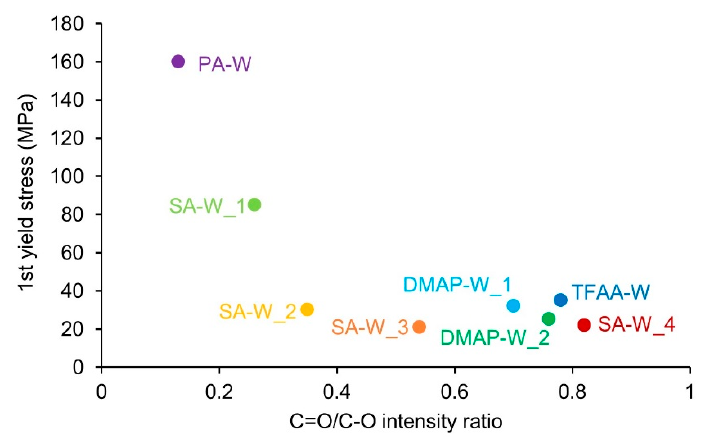
Figure 10. First yield stresses of the propionylated wood specimens, showing the ratio of the IR peak intensity derived from the C=O groups to that of C–O stretching vibrations.